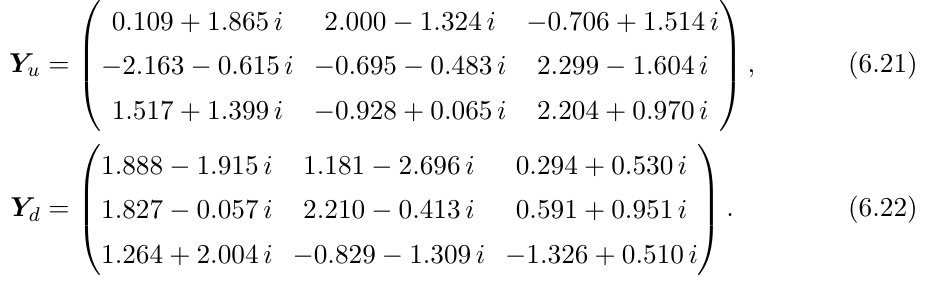
Figure 11 . ∆ (cid:31) K as a function of F 2 , obtained in the original RS model (green) and in our model, | | where the bulk masses are generated dynamically, for different values of and no backreaction (solid and dashed lines, respectively). In the left (right) figure we have fixed m g = 15 TeV (25 1